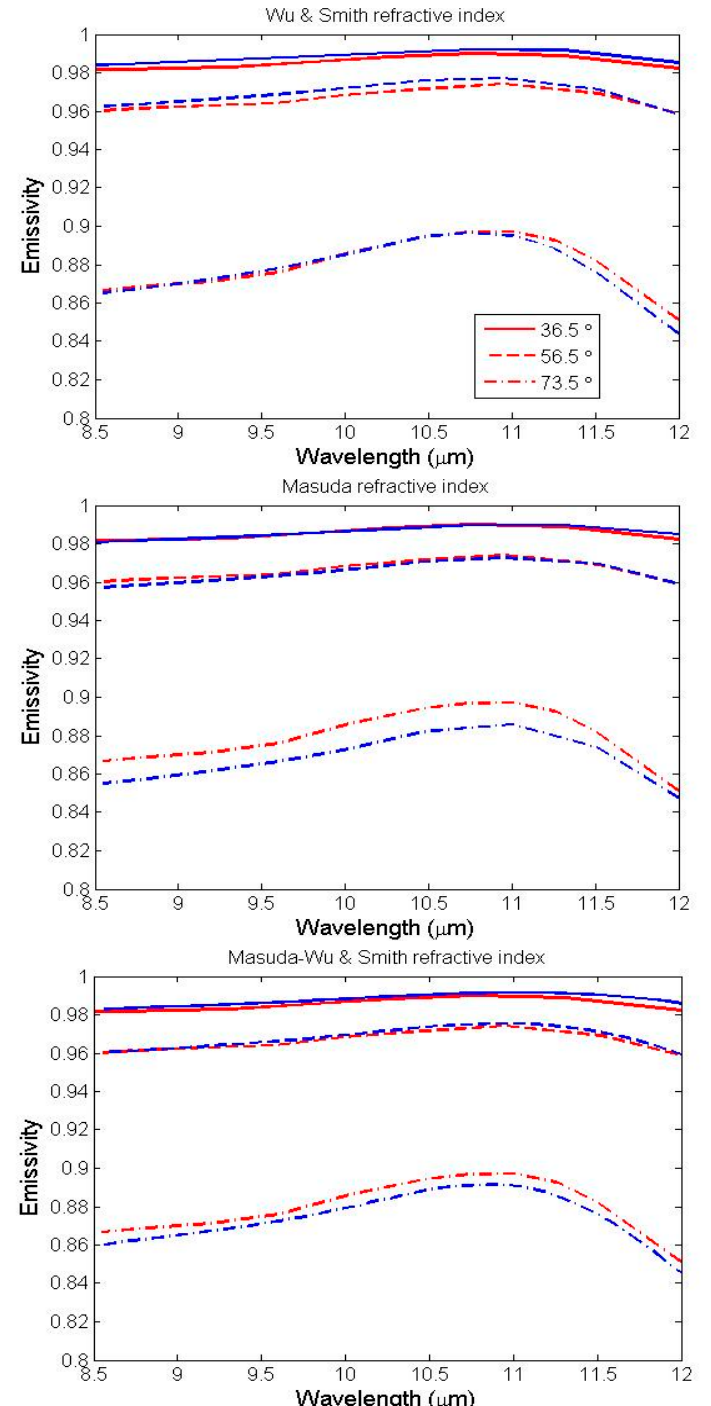
Figure 5. Comparison between in situ-measured sea surface emissivity spectra (red) and those simulated using the Wu and Smith model and the refractive indices from Wu and Smith, Masuda, and the average of Wu and Smith and Masuda (blue). The wind speed is set to 5 m/s.